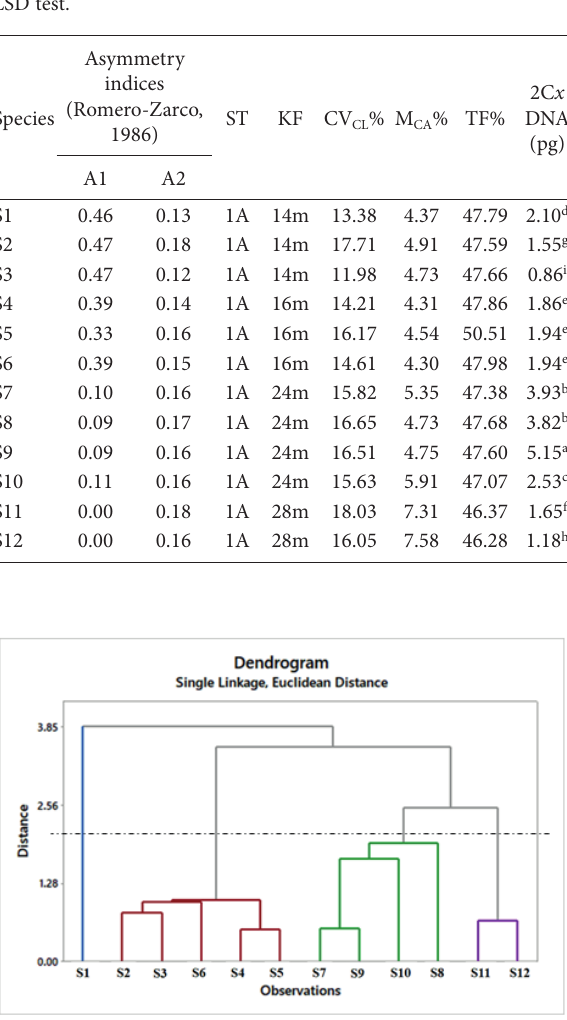
Figure 4. Dendrogram shows relationships of similarity among studied 12 berry species related to all chromosomal characteristics, constructed using Euclidean distance and Single method; cophenet- ic correlation r =